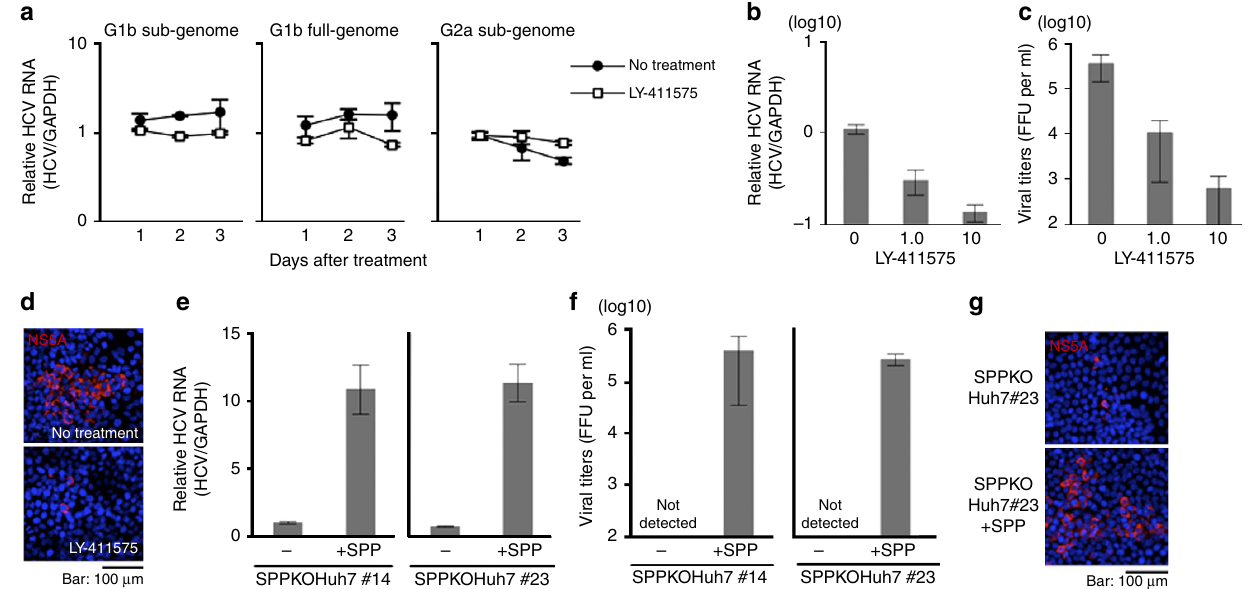
Figure 5 | SPP is an essential host factor for HCV propagation. ( a ) Sub- and full-genomic genotype 1b replicon (left and middle) and sub-genomic genotype 2a replicon (right) cells were treated with LY-411575 (1 m M) for 3 days. The amounts of HCV RNA were determined by qPCR. The data represent the mean ± s.d. of 2 experiments performed with a cell line representative of each replicon cell line. ( b , c ) Huh7 cells infected with the HCVJFH-1 strain at a multiplicity of infection (moi) of 0.5 were treated with LY-411575 (1 or 10 m M) for 4 days. HCVpropagation was evaluated by qPCR analysis for intracellular HCV RNA. ( b ). Infectious titres in the culture supernatants were determined using a focus-forming assay ( c ). The data represent the mean ± s.d. of two independent experiments. ( d ) Huh7 cells infected with the HCV JFH-1strain at a moi of 0.5 were overlaid with methylcellulose in the presence or